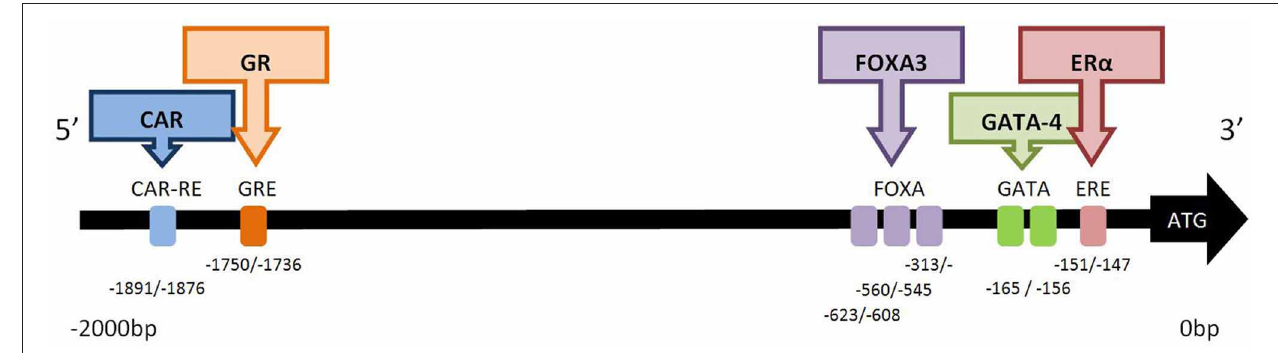
FIGURE 1 | Functional transcription factor binding sites in the 2.0kb 5 (cid:3) -promoter region of CYP2C19. The binding factor CAR (constitutive androstane receptor; NR113) acts at the CAR response element ( − 1891/ − 1876bp). NR113 can also hetero-dimerise with retinoid X receptor (RXR) and pregnane X receptor (PXR) to transactivate CYP2C19 (Chen et al., 2003). The glucocorticoid receptor (GR; NR3C1) acts at the glucocorticoid response element (GRE) at position − 1750/ − 1736bp (Chen et al., 2003). Hepatocyte nuclear factor 3 gamma (HNF3 γ ) is member of the forkhead box/winged helix family of transcription factors and is also known as